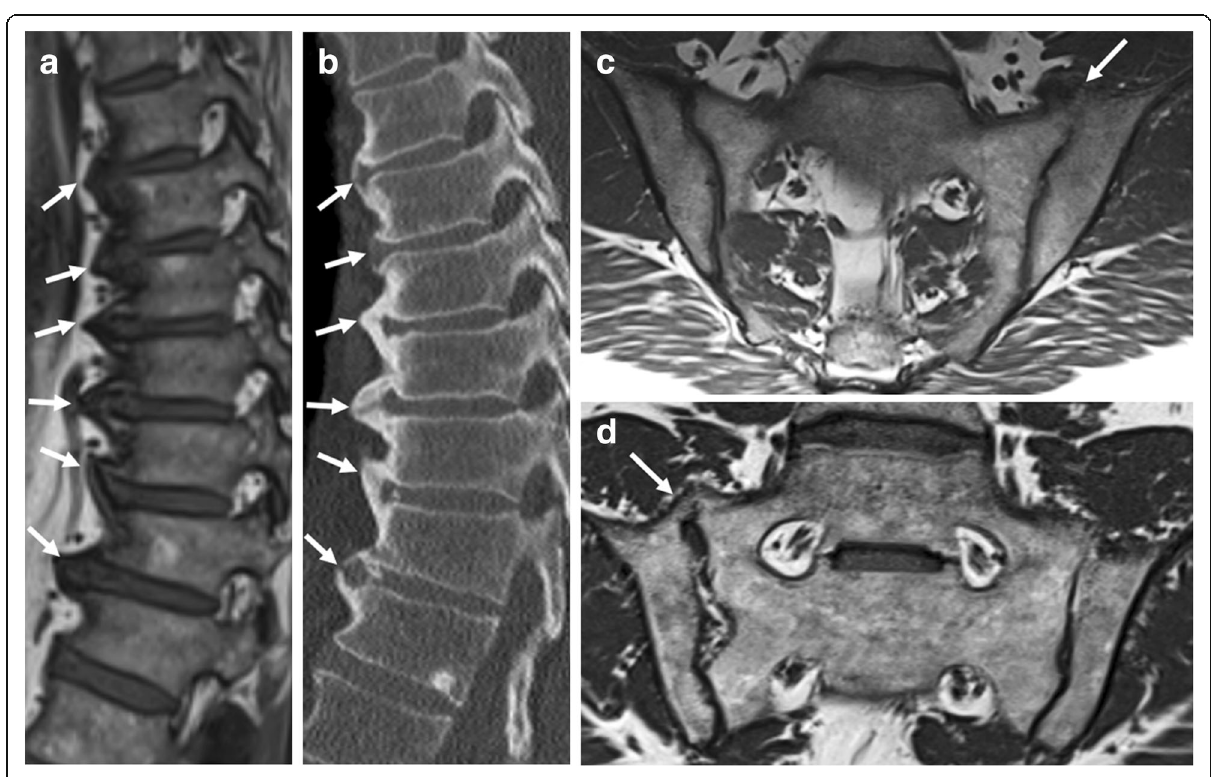
Fig. 10 Pitfalls in imaging and diagnosis of new bone formation: DISH. a Sagittal T1-weighted MR image and ( b ) computed tomography (CT) show hyperproliferative ossification of the anterior longitudinal ligament, resulting in bulky horizontally oriented osteophytes (arrows) with — in this case — an average growth angle of > 45° from vertical. c , d Semicoronal T1-weighted MR images show bridging ossification (arrows) at the anterior and superior aspect of the sacroiliac joints